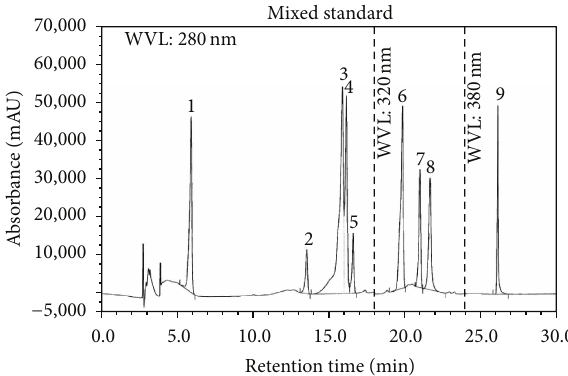
Figure 4: HPLC chromatogram of a standard mixture of polyphe- nolic compounds (1: gallic acid, 2: (+)-catechin, 3: vanillic acid, 4: caffeic acid, 5: ( − )-epicatechin, 6: 𝑝 -coumaric acid, 7: rutin, 8: ellagic acid, and 9: quercetin).